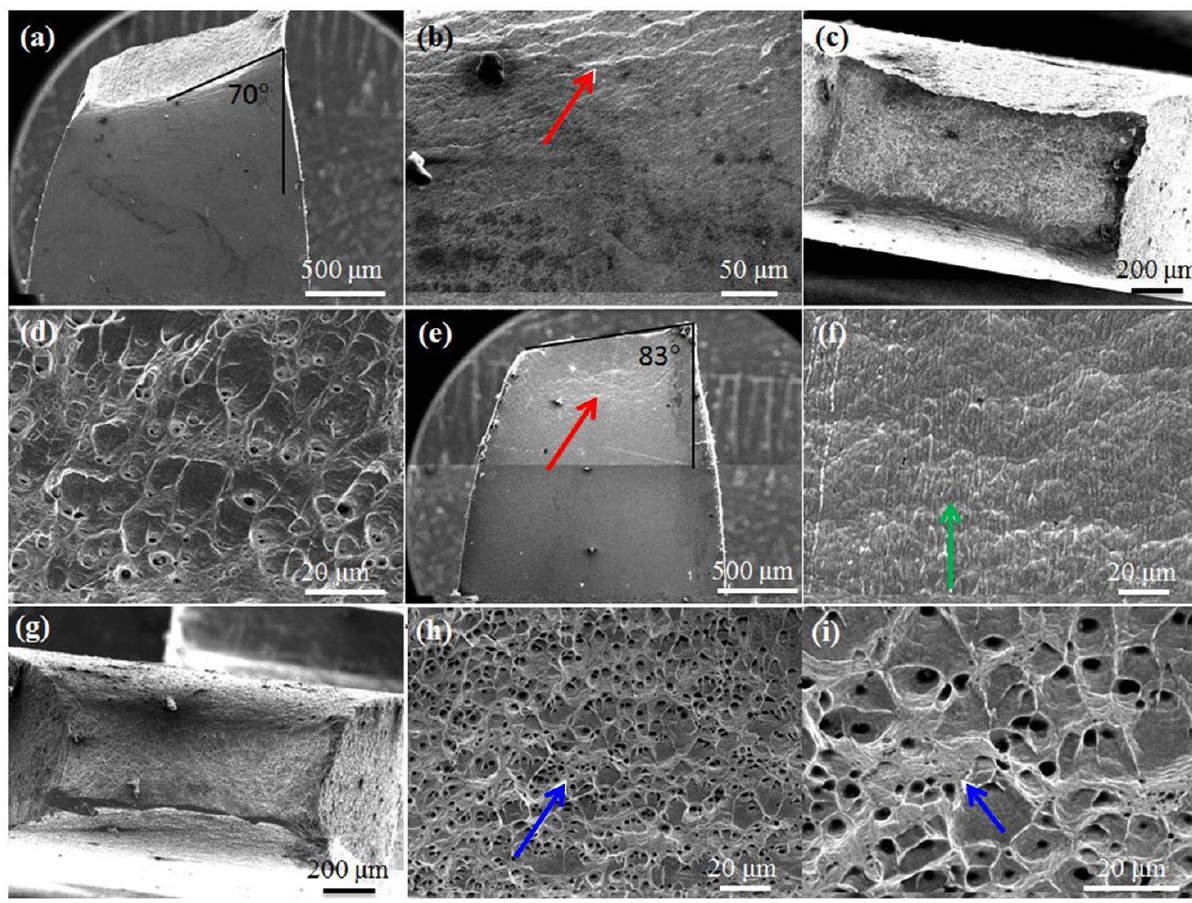
Figure 3: (a) The cross-section of as-ECAPed Cu after fracture; (b) the zoom-in view of location near necking part in Figure 3(a), deformed micro-bands parallel to fracture edge was pointed out by red arrow; (c) the fracture surface of as-ECAPed Cu; (d) the zoom-in view of lo- cation in Figure 3(c); (e) the cross-section of bimodal Cu after fracture, deformed micro-bands in horizontal direction were pointed by red arrow; (f) the zoom-in view of Figure 3(e), elongated recrystallized micro-grains in vertical direction were pointed out by green arrow; (g) the fracture surface of bimodal Cu; (h) the zoom-in view of Figure 3(g), small sub-micro-dimples formed from the UFG regions were pointed out by blue arrow; (i) the zoom-in view of Figure 3(h), small sub-micro-dimples formed from the UFG regions were pointed out by blue arrow.